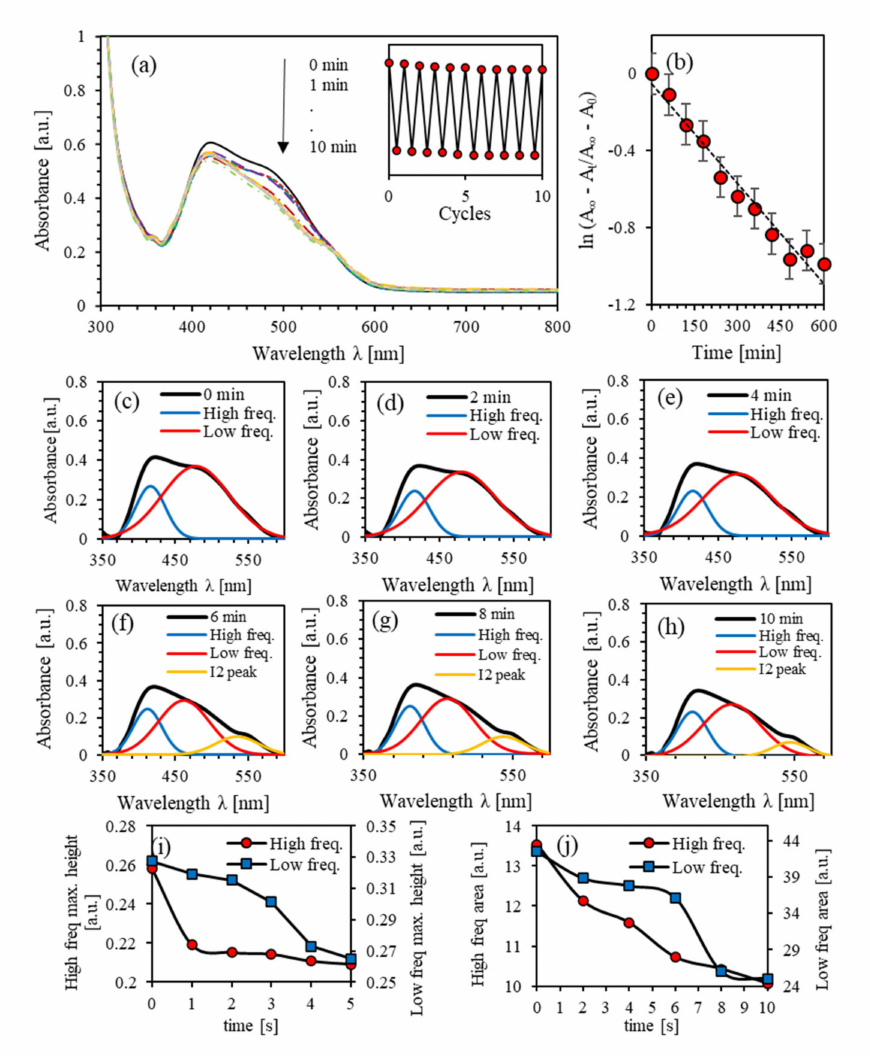
Figure 8. ( a ) Absorbance spectra of (PEO-BDK-MR)/I 2 (1.0%) complex composite thin film for various UV-illumination times, ( b ) the kinetic constants for trans → cis photoisomerization of (PEO- BDK-MR)/I 2 (1.0%) complex composite thin film, ( c – h ) Double peaks fit for the absorbance spectra of (PEO-BDK-MR)/I 2 (1.0%) complex composite thin film for various UV-illumination exposure periods. ( i ) The amplitude and ( j ) integrated area-fit for the dual-peaks of the absorbance for the (PEO-BDK-MR)/I 2 (1.0%) complex composite thin film for various UV-light exposure